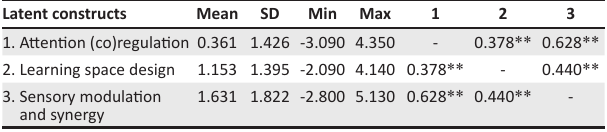
TABLE 6: Means, standard deviations, minimum, maximum and correlations between constructs. Latent